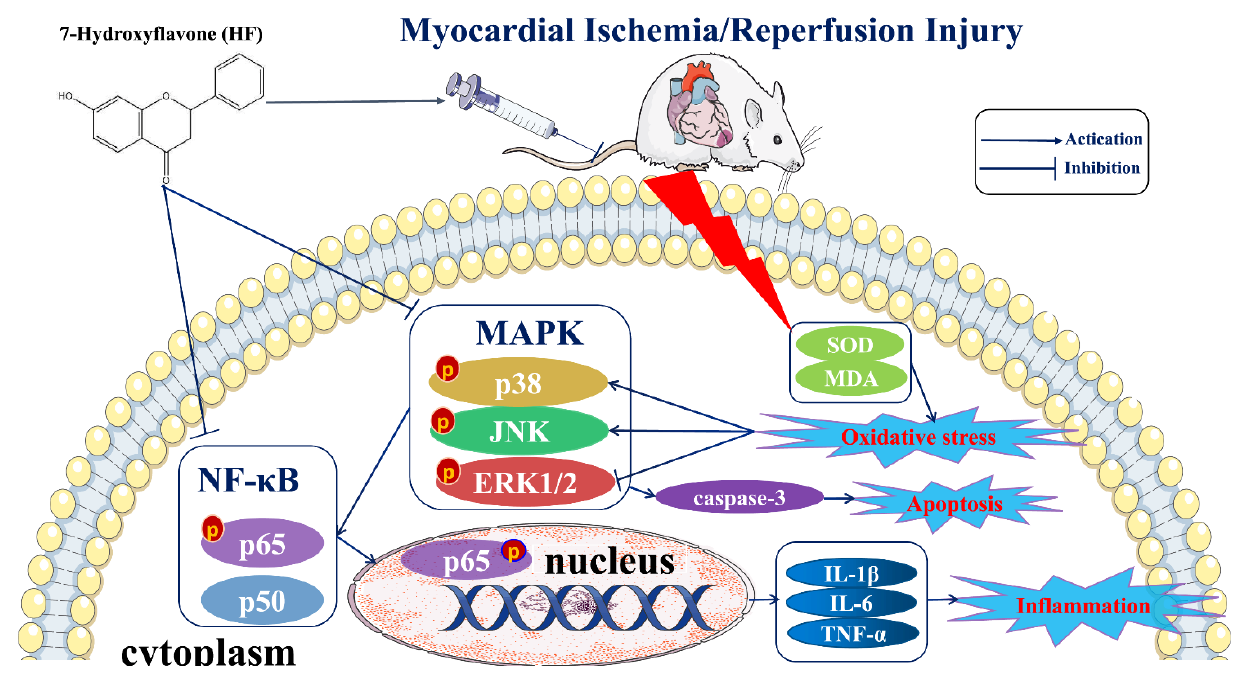
Figure 11. A schematic diagram summarizing the underlying mechanisms in this study. HF can protect the heart from myocardial ischemia/reperfusion injury. The potential mechanisms of this effect can be connected with the activation of the MAPK/NF- κB signaling pathway, reduction in the inflammatory cytokines (IL- 1β, IL -6, and TNF- α) and apoptotic factor (caspase -3), and the enhancement of the antioxidant levels (SOD and MDA).